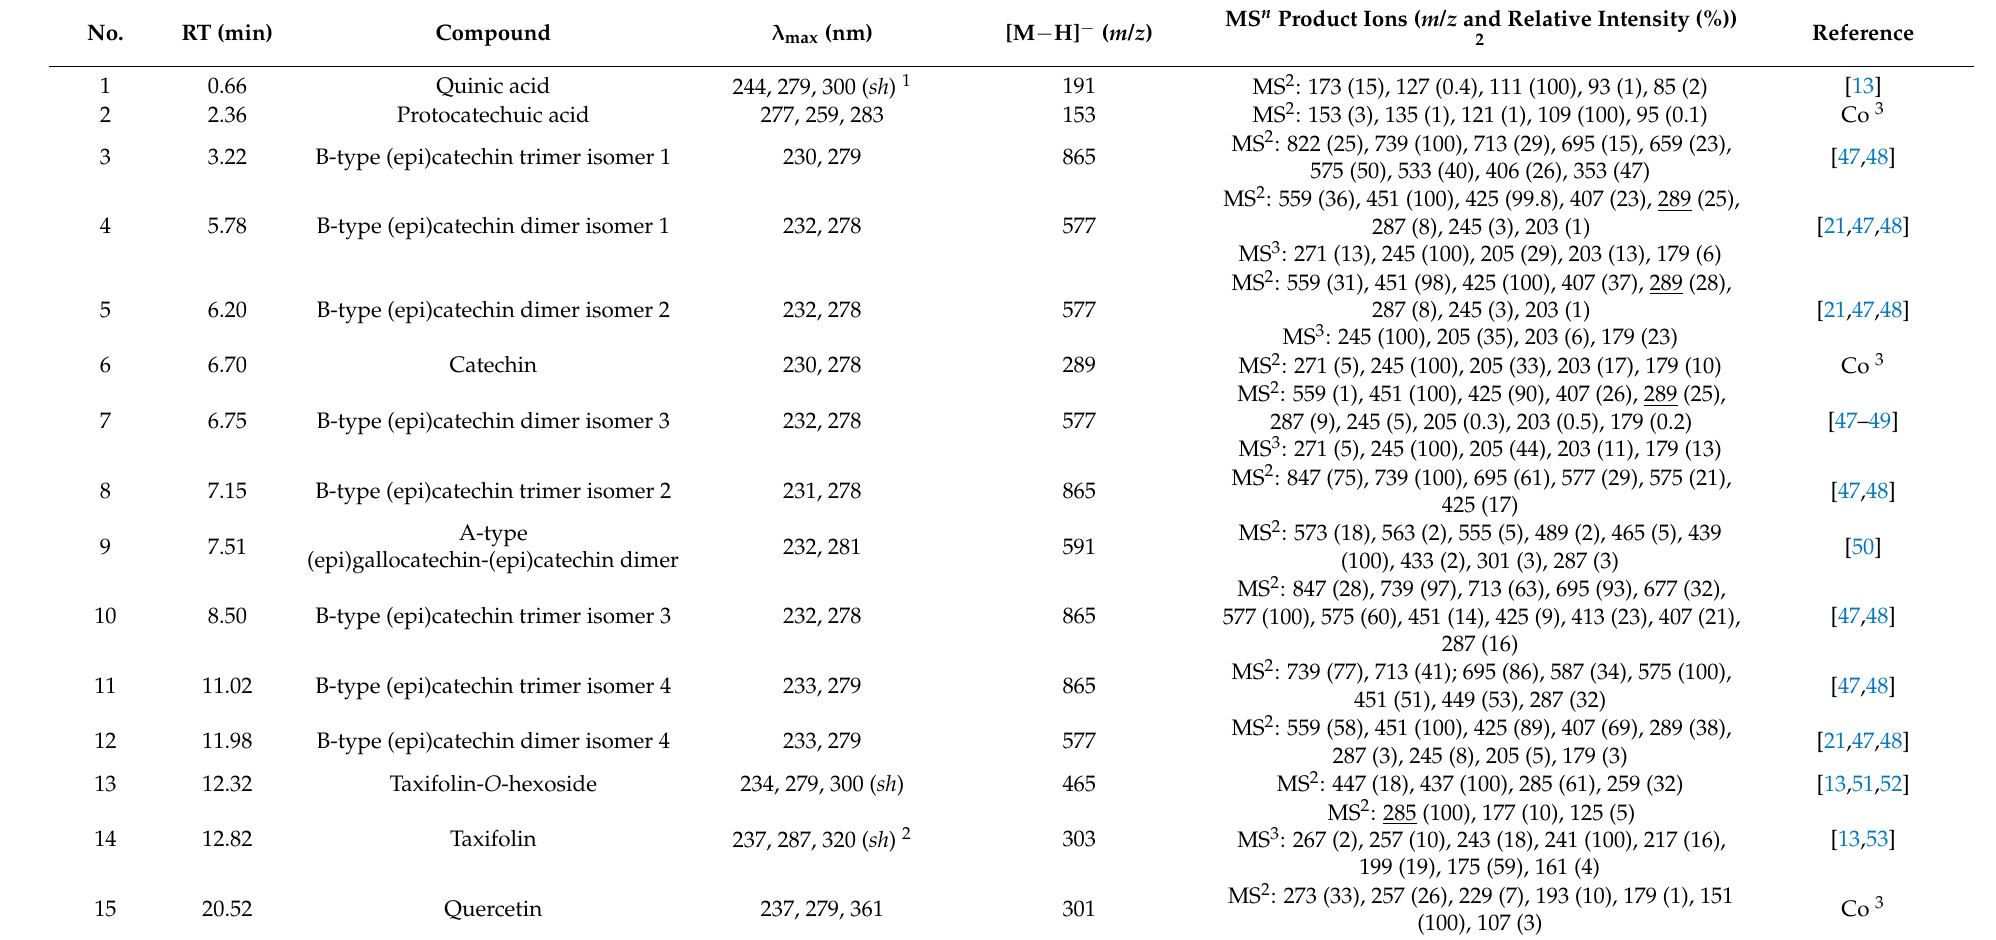
Table 3. UHPLC-DAD-MS n data of compounds identified in Pinus pinaster Ait. and Pinus pinea L. bark polar